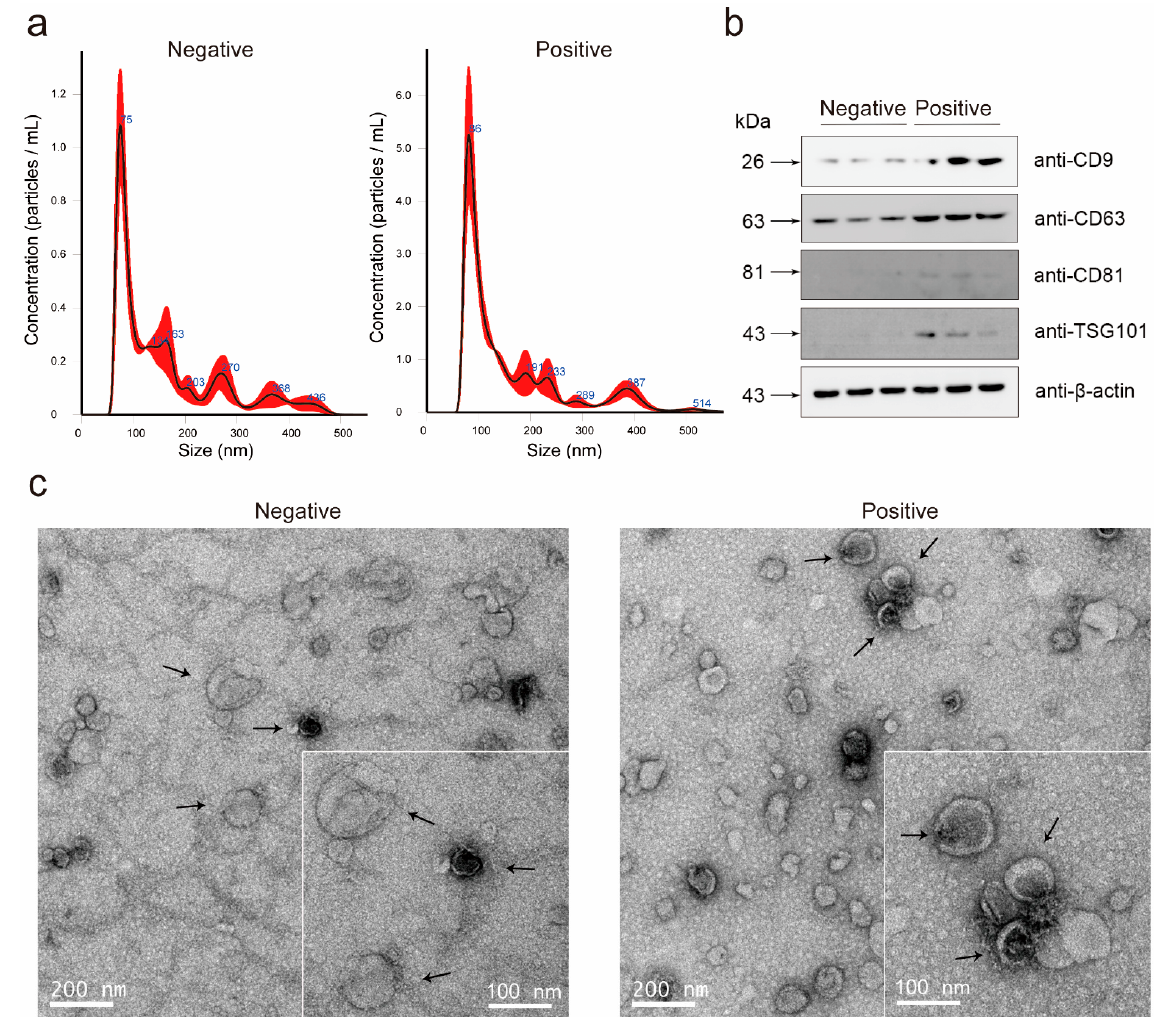
Figure 1. Characteristics of urinary exosomes. ( a ) Nanotracking analysis shows the size distribution of the urinary exosomes of the biopsy-negative and biopsy-positive patients. The particle size of the urine exosomes was concentrated at 40–160 nm in both the biopsy-negative and biopsy-positive patients. The particle size peak distribution of the urinary exosomes of the biopsy-negative and biopsy-positive patients was at 75 nm and 86 nm, respectively. ( b ) Analysis of the expression of the exosomal markers CD9, CD63, CD81, TSG101 and internal control ACTB using Western blots. ( c ) Transmission electron microscopy graphs show the morphology of the urine exosomes of the biopsy-negative and biopsy-positive patients. The arrows were used to point the representative exosomes.